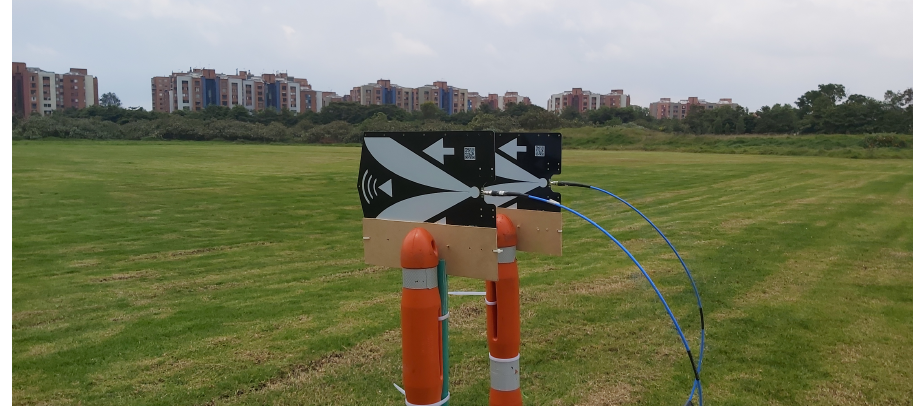
Figure 4. Free space experimental setup with no objects.